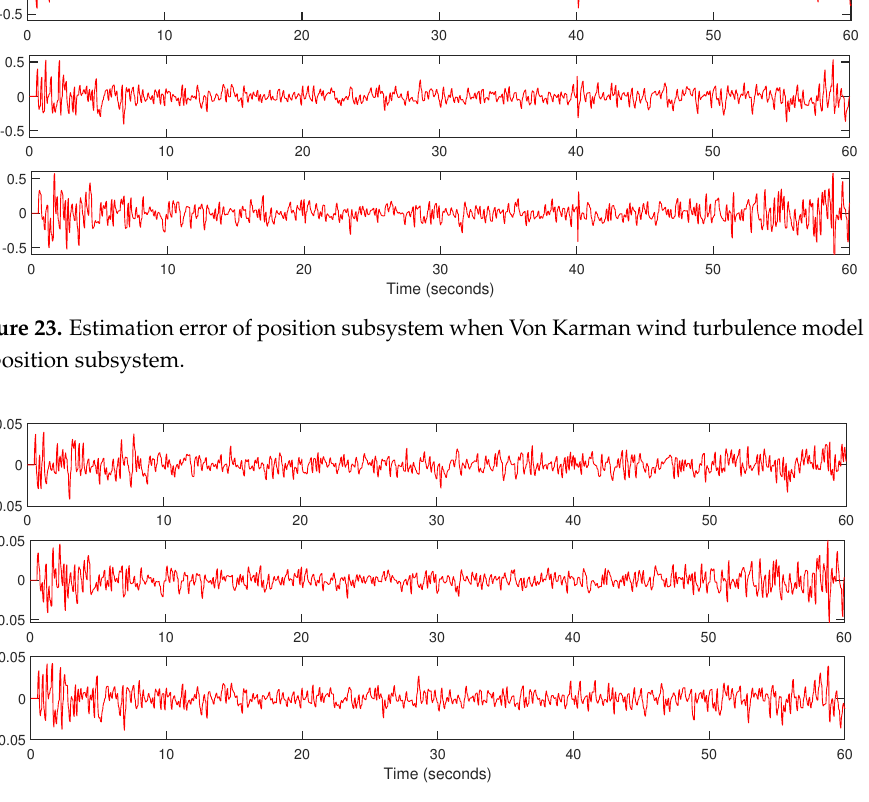
Figure 24. Estimation error of attitude subsystem when Von Karman wind turbulence model is applied to the attitude subsystem.